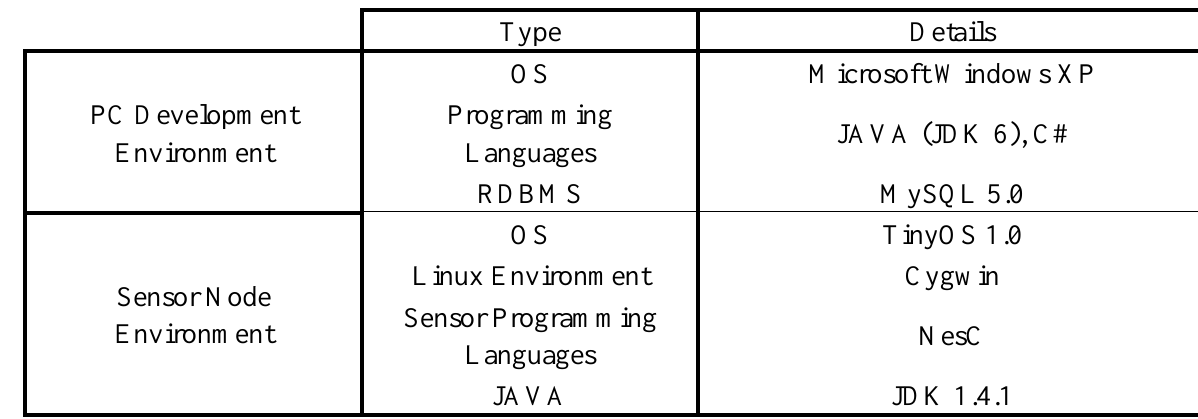
Table 2. Software